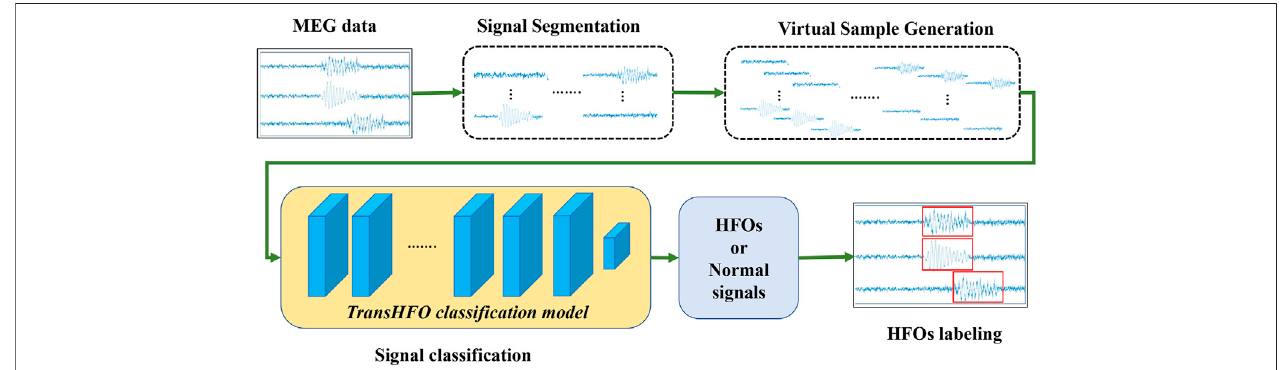
FIGURE1| TheproposedTransformer-basedHFOdetectionframework isdesignedspeci fi callyforthepresurgicaldiagnosisofbiomedicalone-dimensionalMEG signal data. Brie fl y, the HFO classi fi cation framework includes signal segmentation, signal augmentation, TransHFO signal classi fi cation, and signal labeling. This framework achieves more robust and reliable performance on HFO classi fi cation than baseline models. Furthermore, we fi nd that shallow TransHFO ( < 10 layers) outperforms deep TransHFO ( ≥ 10 layers) on most data augmented factors, revealing the importance of human labeled data and the potential of deep-learning methods for automatic diagnosis of medical